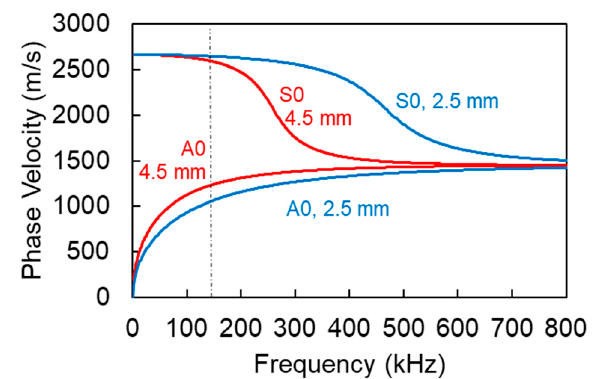
Figure 8. Dispersion curves for S0 and A0 modes for TRC with different thickness and longitudinal and shear wave velocity 3000 m/s and 1550 m/s respectively. The vertical dash-dot line denotes the resonant frequency of the receivers.